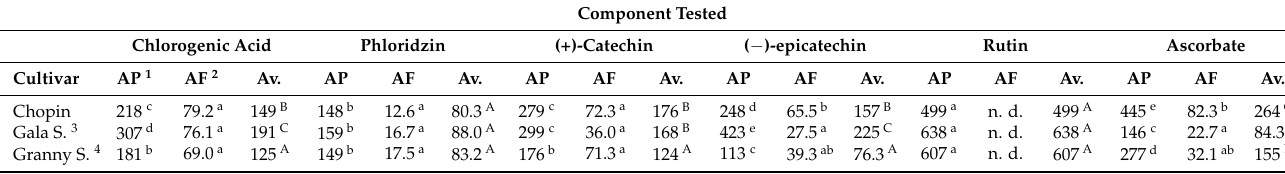
Table 3. Distribution of individual phenolic compounds and total ascorbate concentrations in the apple peel and the apple flesh depending on the cultivar (mg kg − 1